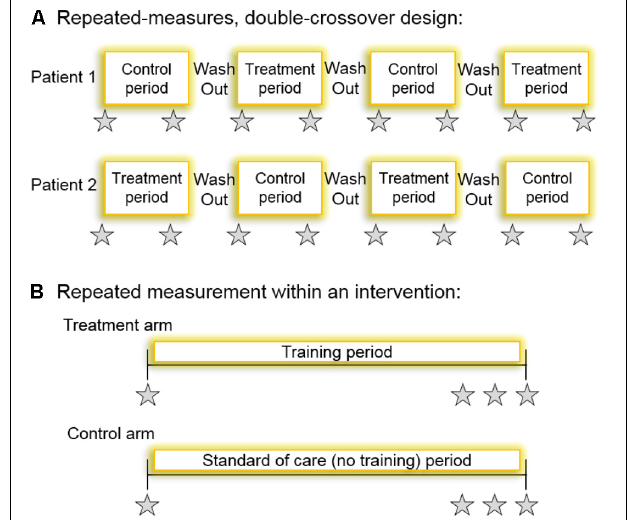
FIGURE 2 | (A) A schematic for a repeated-measures double-crossover study design which, if the patient-by-treatment interaction term were statistically significant, would accurately indicate the presence of inter-individual variability. All patients undergo all interventions twice. The type of trial each participant first undergoes should be randomized and the primary outcome is measured at the beginning and the end of each intervention period. The time between interventions would have to be sufficient such that training effect was washed out. (B) Perhaps a more practical and logistically feasible method for determining the technical error of measurement, and thereby identifying non-responders, is a randomized controlled intervention where the primary outcome variable is measured repeatedly within an intervention. Participants are randomized to either the control arm (no training) or the treatment arm (exercise training). Ideally, the variable would be repeatedly measured within a time frame where intervention-induced changes are unlikely (e.g., measuring HbA1c three times within a 2-week period towards the end of a long-term training intervention). Gray stars indicate repeated measurement of the variable, HbA1c, for